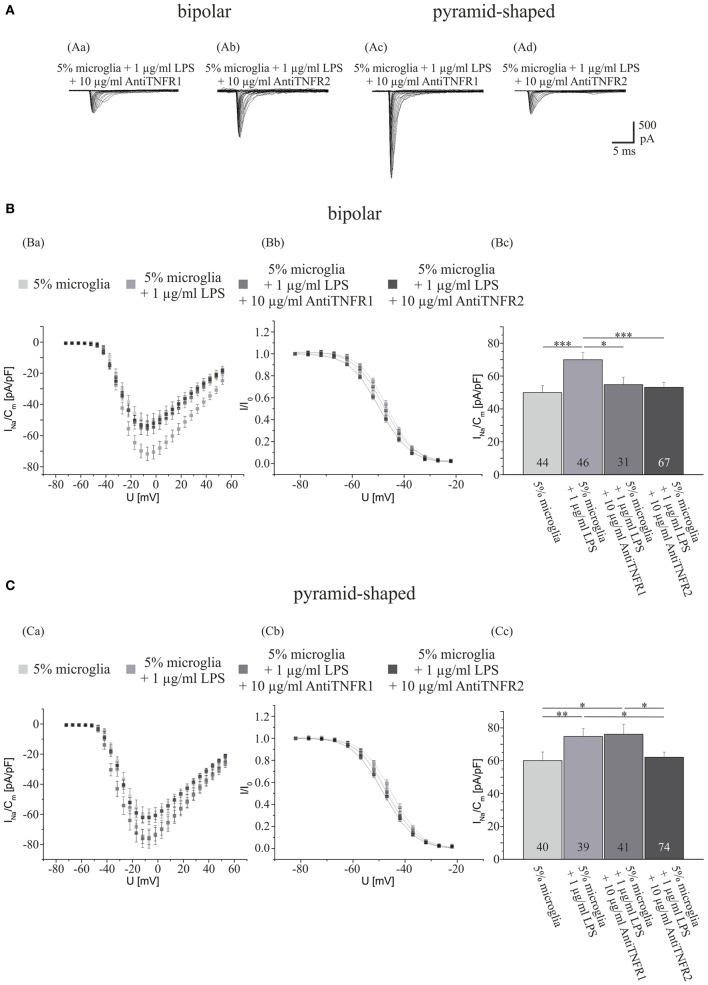
Effects of preincubations with antibodies against TNFR 1 or 2 on LPS-induced upregulation of Na+ current density in different types of neurons. (A) Series of original current recordings from bipolar neurons elicited by step depolarizations in 5 mV increments starting from a holding potential of −77 mV. Analysis of the whole data set for (B) bipolar and (C) pyramid-shaped cells. (Ba,Ca) Average current–voltage relationships for Na+ currents normalized to capacitance recorded from neurons cultured in the presence of microglia and 4 days of exposure to 1 μg LPS and 4 days of either antibody against TNFR 1 or 2. (Bb,Cb) Influence of TNFR 1 and 2 blockage on steady-state inactivation of Na+ currents. Solid lines represent fits to the modified Boltzman equation as detailed in Section “Materials and Methods.” (Bc,Cc) Peak Na+ current densities of neurons cultured in the presence of microglia and 4 days of exposure to 1 μg LPS and 4 days of either antibody against TNFR 1 or 2 determined at test potentials of 12 mV starting from holding potentials of −77 mV. Note that the Na+ current density of bipolar neurons is decreased by both antibodies against TNFR 1 and 2, whereas the Na+ current density of pyramid-shaped neurons is only decreased by antibodies against TNFR 2 to control levels. All recordings performed at day 7 in culture after incubations with test substances for 4 days following a preculture of 3 days. Numbers in bar charts indicate numbers of cells recorded from. Database for every column derived from 7 to 15 different preparations. Error bars represent means ± SE, *p < 0.05, **p < 0.01, and ***p < 0.005.